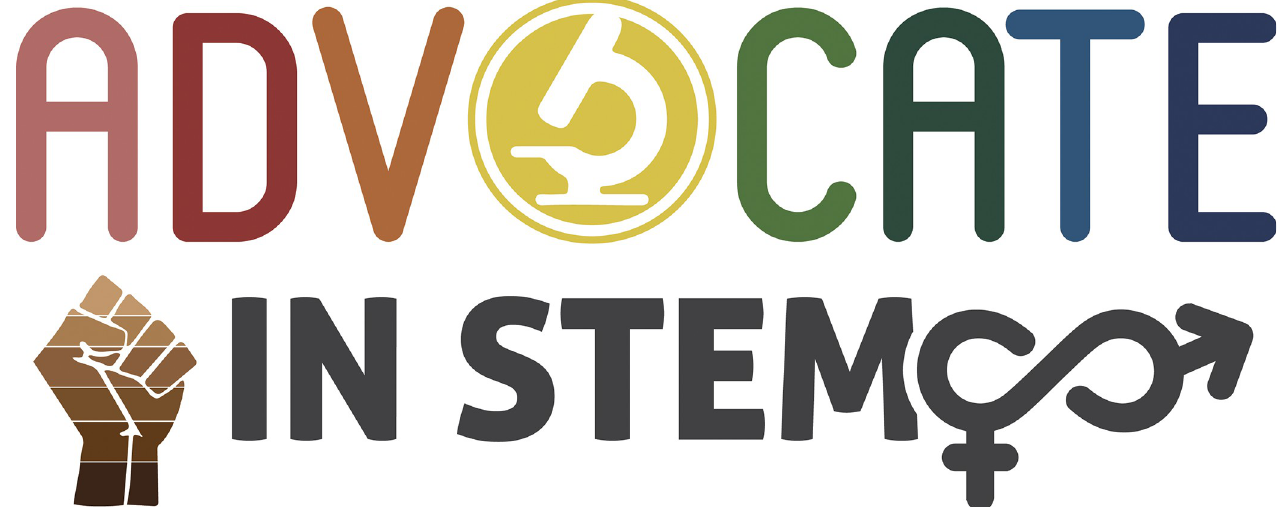
Fig 1. Advocate in STEM. A drawing that can be displayed on all presentations and lab spaces, indicating a lab’s goal to advocate for all